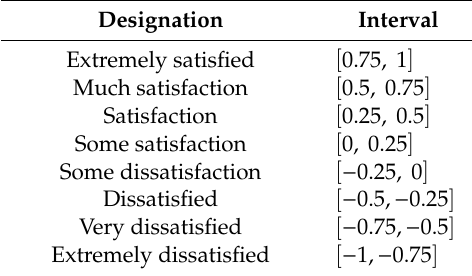
Table 9. Scale of satisfaction (adapted from